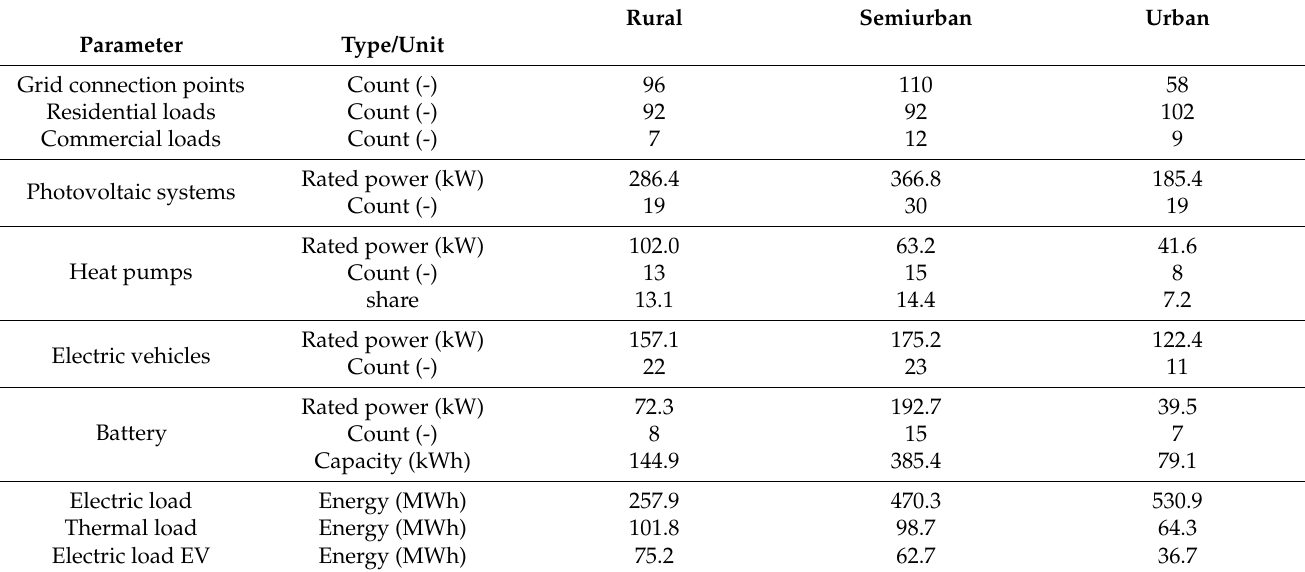
Table A3. Scenario assumptions for scenario year 2030, adapted from [2].